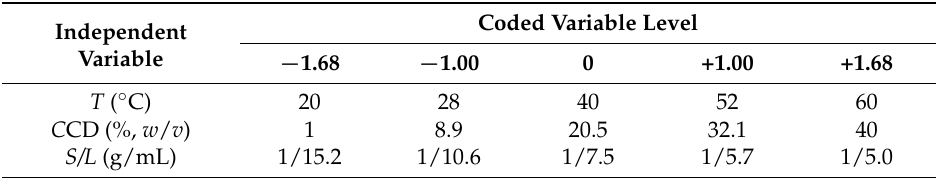
Table 1. Experimental values and coded levels of the independent variables used for the central composite